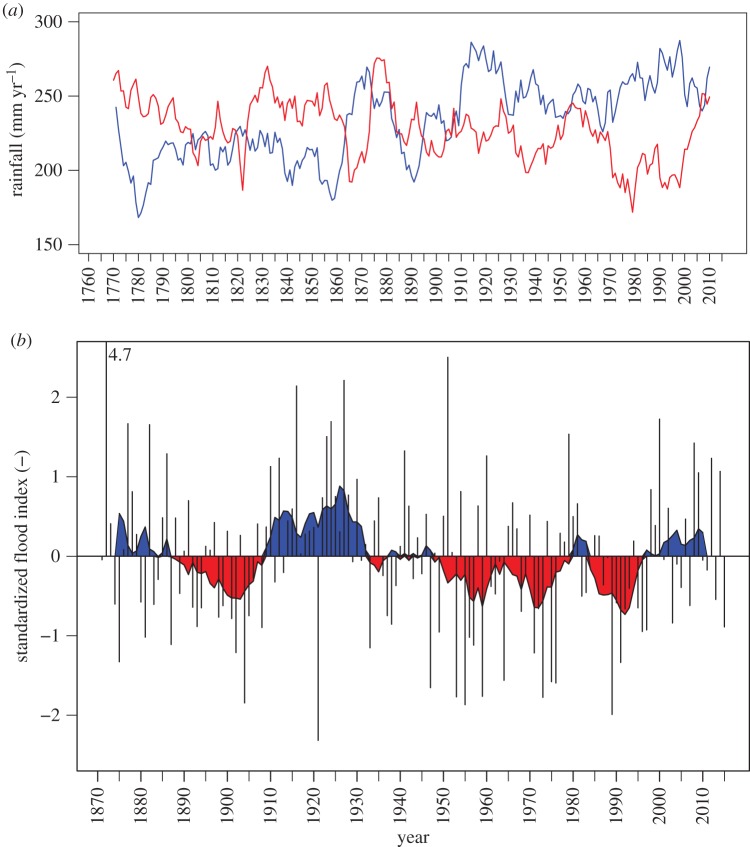
Climate variability and flooding. (a) England and Wales precipitation seasonality (1776–2015); the blue line shows winter (DJF) precipitation; the red line indicates summer (JJA) precipitation. Data from [4]; http://www.metoffice.gov.uk/hadobs/hadukp/. (b) Annual mean flood index (1871–2015). The blue and red shading shows flood-rich and flood-poor periods respectively Data from ref. [5]; https://crudata.uea.ac.uk/cru/data/lwt/.